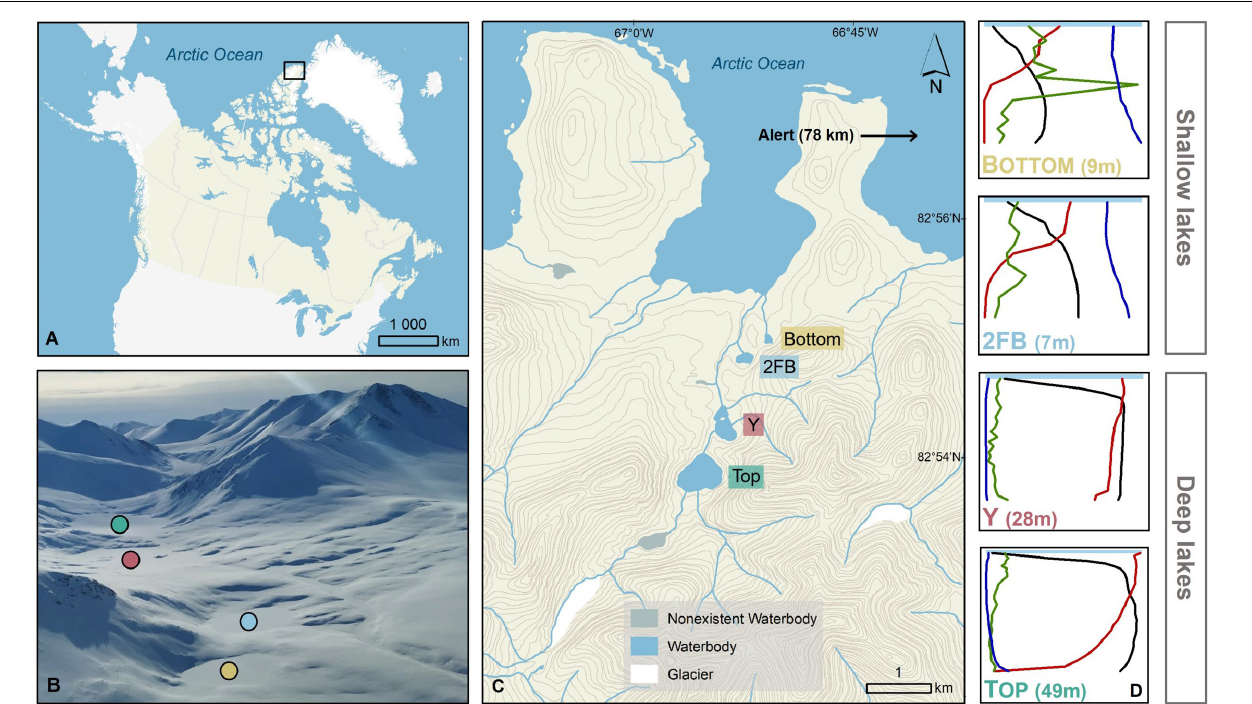
FIGURE 1 | Stuckberry Valley lakes. (A) Stuckberry Valley is located on the northern coast of Ellesmere Island on the edge of the Arctic Ocean (B) Aerial photograph of the four lakes surrounded by mountains. In late May, lakes were still covered with ice and snow (photo credit: Addison Gilpin-Payne). (C) The valley includes four lakes. (D) Chemical and physical gradients in the water columns of the four Stuckberry Valley lakes. For all four lakes, the maximum depth is in parentheses. Each profile parameter is associated with a color: green, chlorophyll a ; blue, specific conductivity; black, temperature; red, dissolved oxygen. Complete profiles with values are available in Supplementary Figure 1 . Maps were created using ESRI ArcMap (v.10.7). The digital elevation model comes from Natural Resources Canada (2001) and the boundary files are from Statistics Canada (2016).